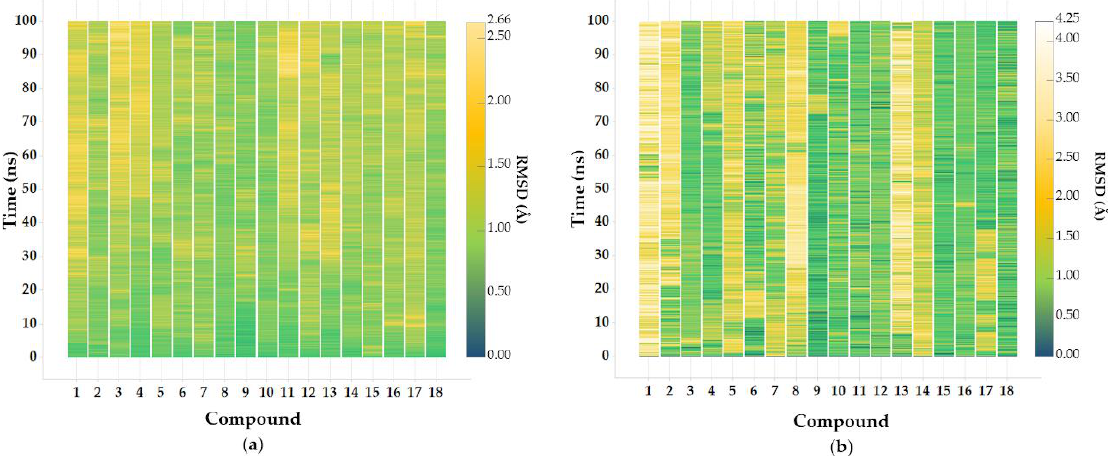
Figure 4. RMSD evolution of ( a ) protein and ( b ) ligand with respect to the protein, for each 100 ns MD simulation using frame 0 as reference. The RMSD ranges are 0–2.66 Å in a and 0–4.25 Å in b (dark green-yellow-white color scale corresponds to 0 to 4.25Å values).